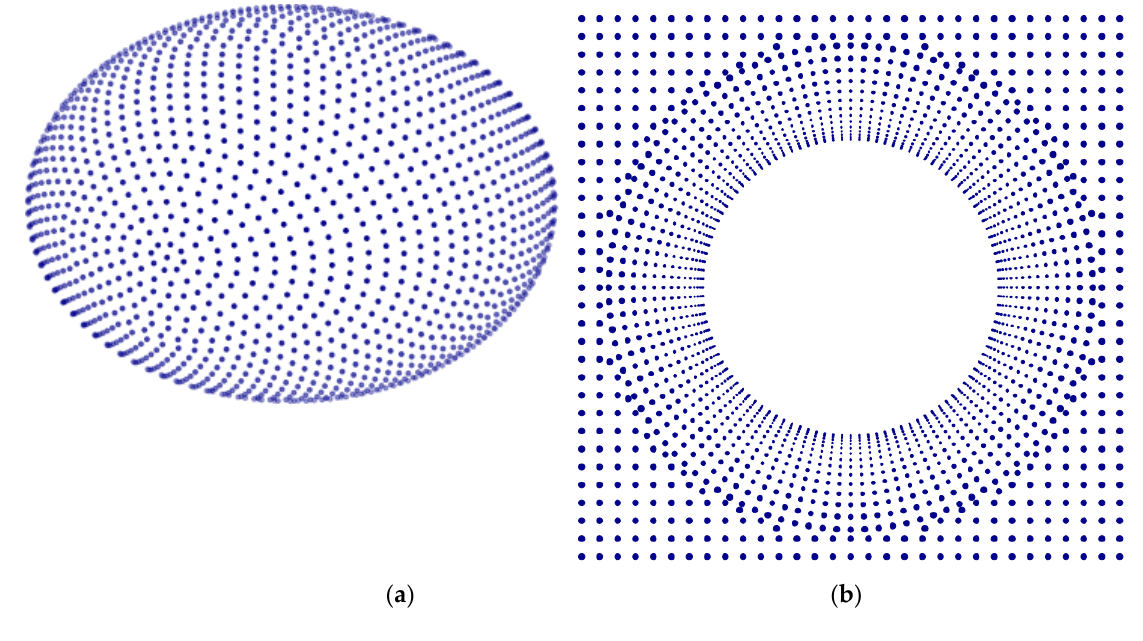
Figure 1. Location of computing nodes: on the body surface ( a ), in the section of the computational domain ( b ).